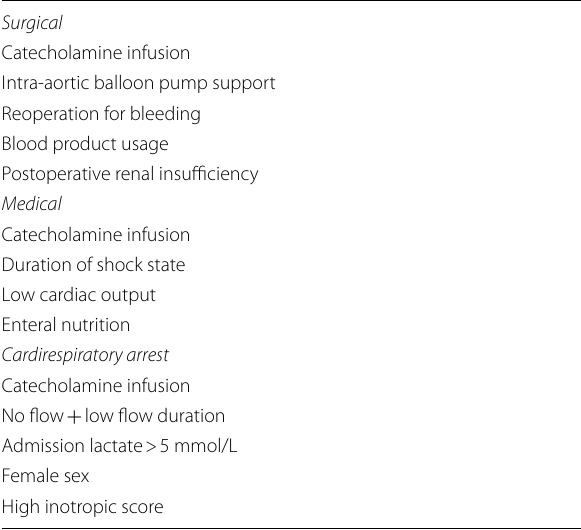
Table 1 Main risk factor of NOMI in critically ill patients according to their etiology